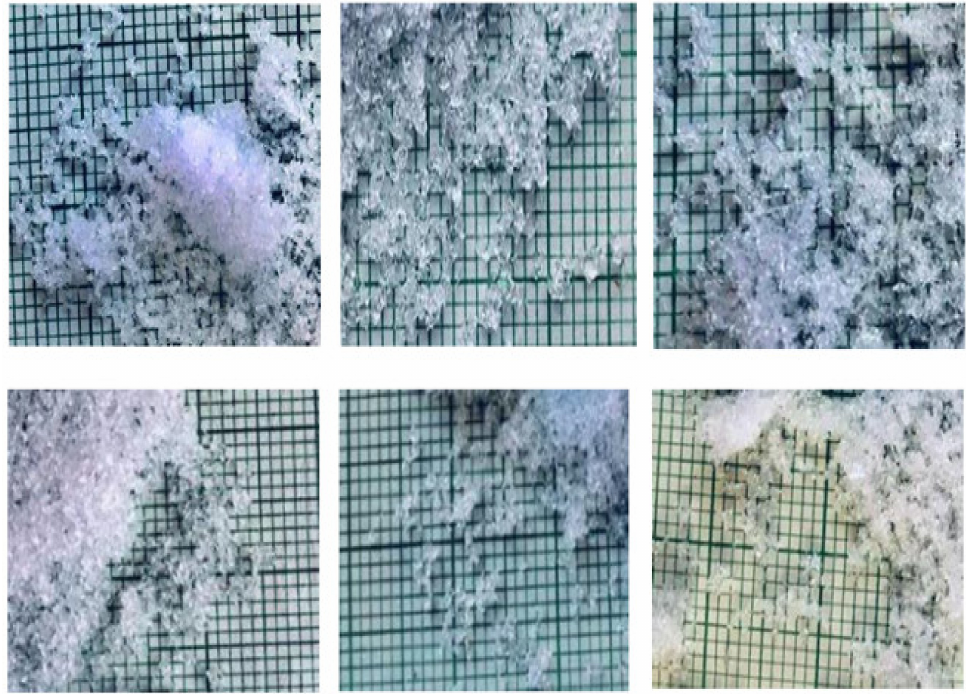
Figure 16. Snow grains from the moderately metamorphosed